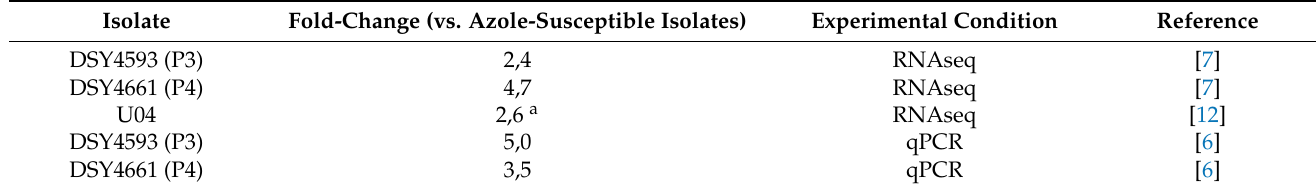
Table 1. CDR1 expression in different isolate backgrounds. Isolate Fold-Change (vs. Azole-Susceptible Isolates) Experimental Condition